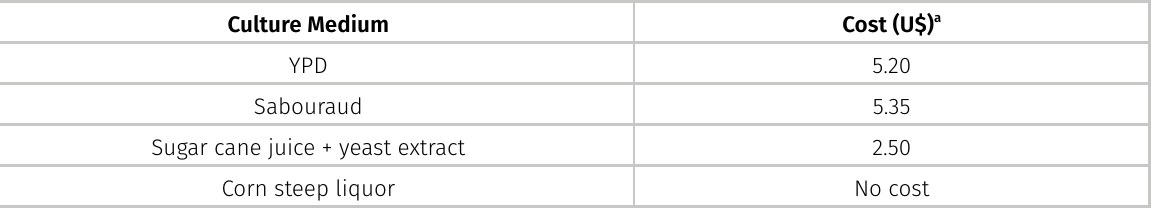
Table III. Nutritional composition cost of one liter of culture medium for fungi. Expenses with distilled water are not